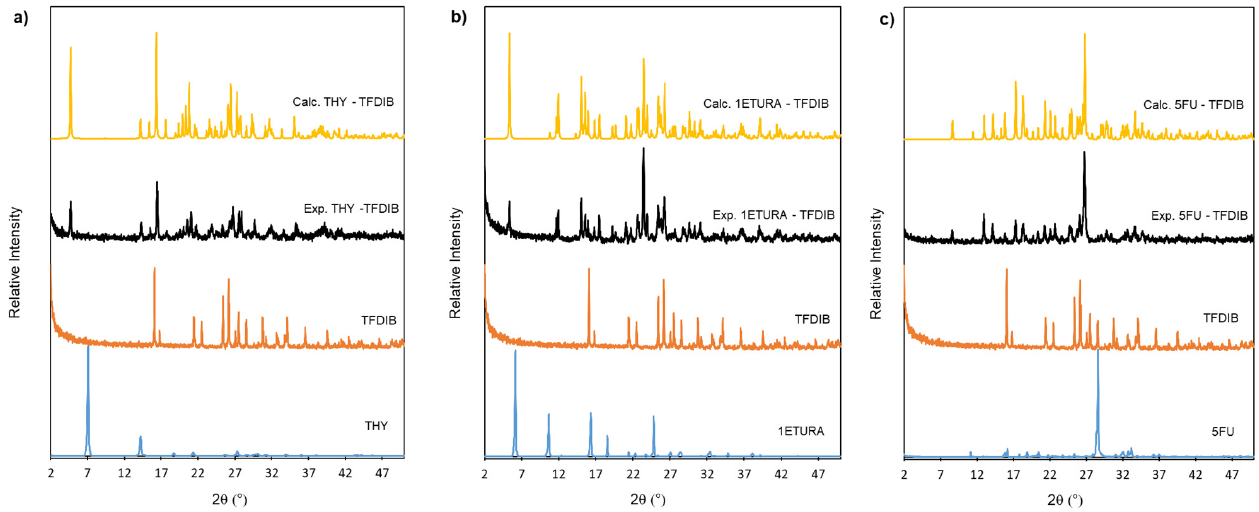
Figure 1. Comparison of calculated and experimental PXRD patterns for the cocrystals 1 ( a ), 2 ( b ), and 3 ( c ) and their respective precursors.